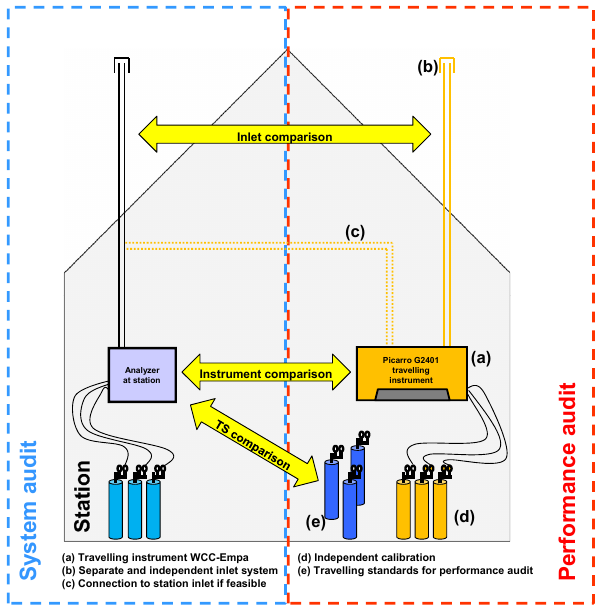
Figure 2. Schematic of the comparison procedure for the ambient air measurements during audits by